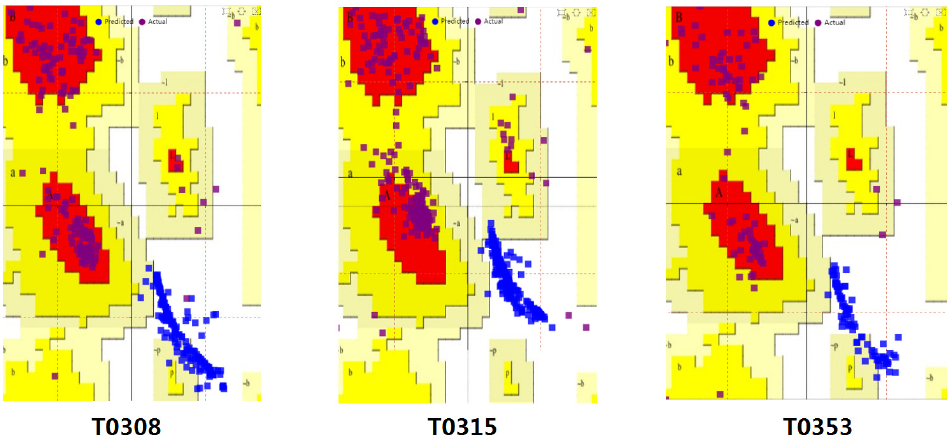
Figure 16. The Ramachandran Plot of T0308, T0315, and T0353 predicted structure ( blue ) and actual structure ( purple